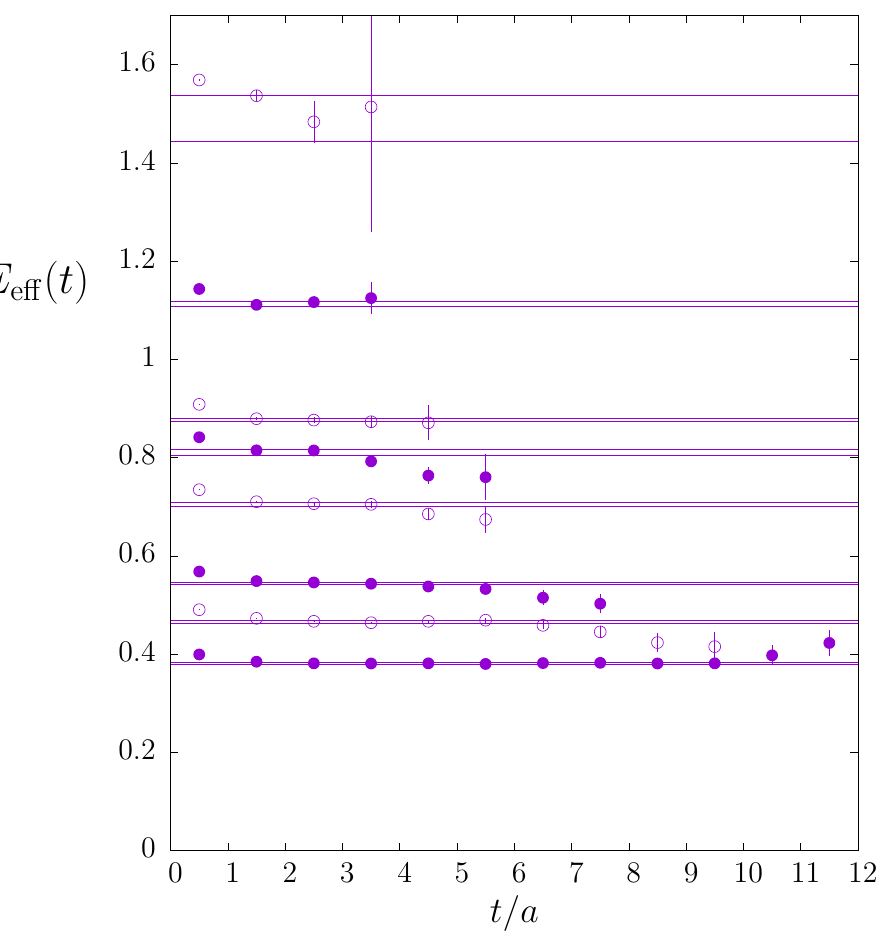
Figure 1 . Effective energy of the ground state of the winding flux tube from which we extract the string tension. For β = 6 . 50 , 6 . 338 , 6 . 235 , 6 . 0625 , 5 . 99 , 5 . 80 , 5 . 6924 in ascending order. Pairs of lines represent ± 1 σ error bands for the best estimates of the